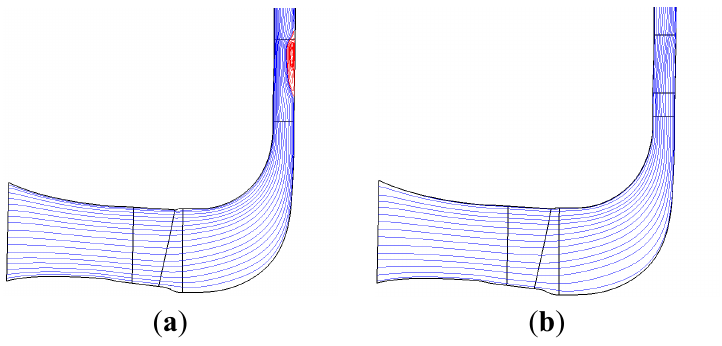
Figure 9. Meridional streamline: ( a ) Original design; ( b ) Optimization design 2.